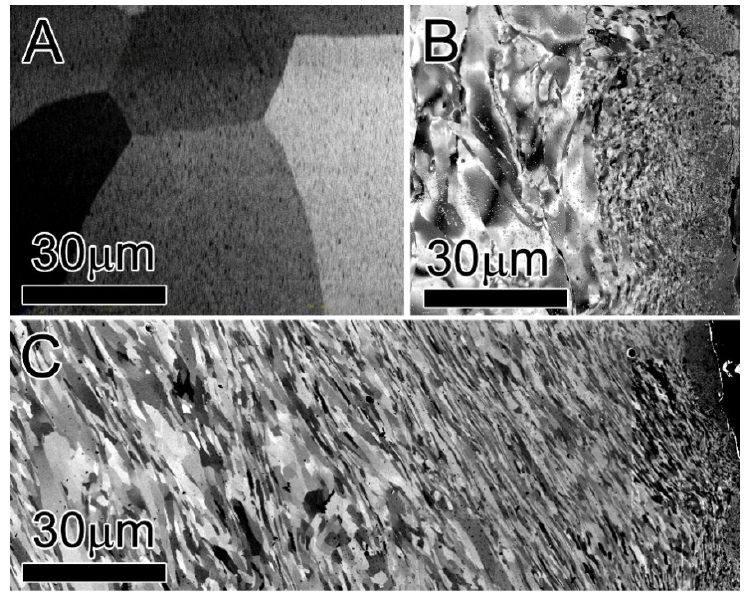
Figure 1. ( a ) Initial microstructure of the ARMCO Iron plate; ( b ) Surface